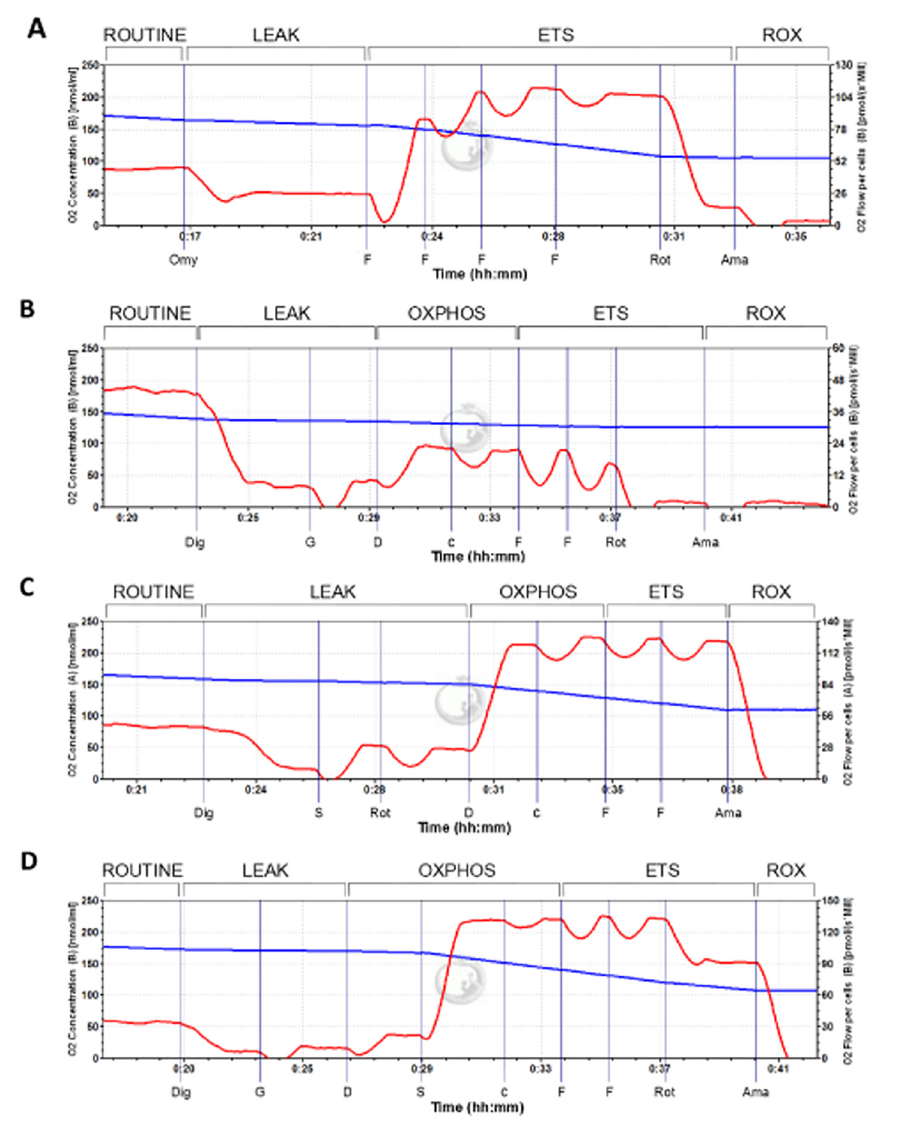
Fig 1. Oxygraphic example output of protocols with intact and permeabilized INS-1 832/13 cells (at normoxia). (A) Protocol with intact cells, (B) SUIT CI protocol with permeabilized cells with glutamate as only reducing substrate, (C) SUIT CII protocol with permeabilized cells with succinate as only reducing substrate, ( D) SUIT CI+II protocol with glutamate and succinate as reducing substrates. The blue line represents the oxygen concentration (nmol O 2 /mL) in the experimental chamber. The red line represents oxygen flux (pmol O 2 /s/10 6 cells), the negative time derivate calculated from the measured oxygen concentration, normalized to the number of cells. ROUTINE: ROUTINE respiratory state of basal respiration, LEAK: LEAK respiratory state of uncoupled respiration, OXPHOS: OXPHOS respiratory state of maximum phosphorylative capacity, ETS: ETS respiratory state of the maximum capacity of the ETS, ROX: ROX respiratory state of residual oxygen consumption, Dig: digitonin, G: glutamate, D: ADP, S: succinate, c: cytochrome c , F: FCCP, Rot: rotenone, Ama: antimycin